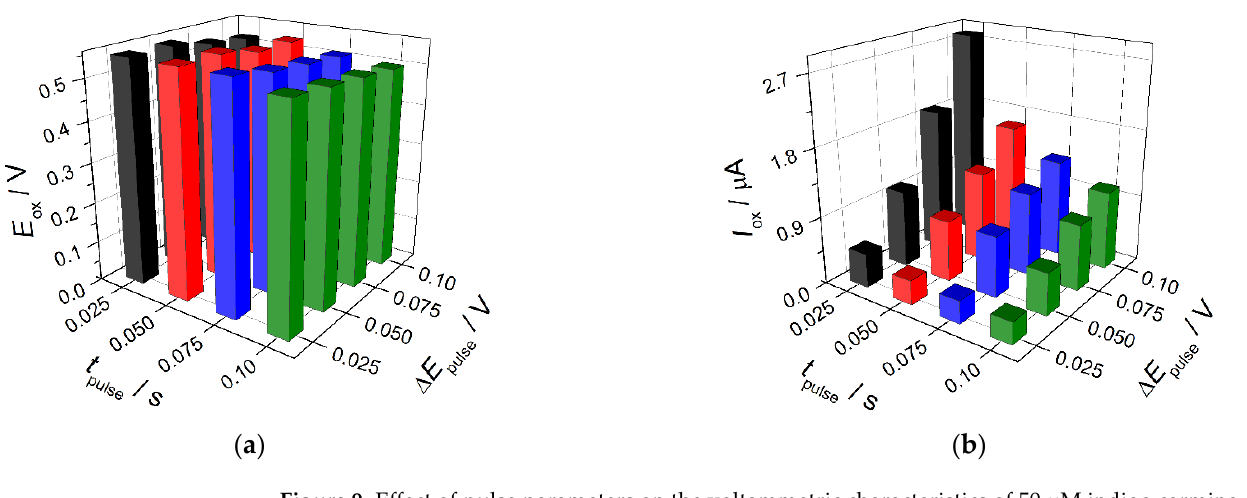
Figure 9. Effect of pulse parameters on the voltammetric characteristics of 50 µM indigo carmine at the SeO 2 –CPB/GCE in phosphate buffer pH 5.0: ( a ) the changes of the oxidation potential; ( b ) the changes of the oxidation currents.